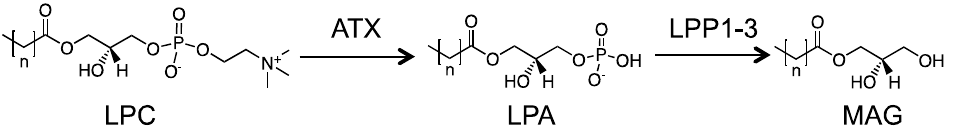
Figure 2. Overview of the LPA signaling axis. Extracellular LPA is produced from LPC by the lysophospholipase D activity of ATX. LPA then signals through at least six known G-protein coupled LPA receptors to mediate its host of physiological and pathological effects. LPA is rapidly turned over by the eco-activity of LPP1-3 into inorganic phosphate and monoacylglycerol (MAG), which apart from 2-arachidonoylglycerol, does not affect